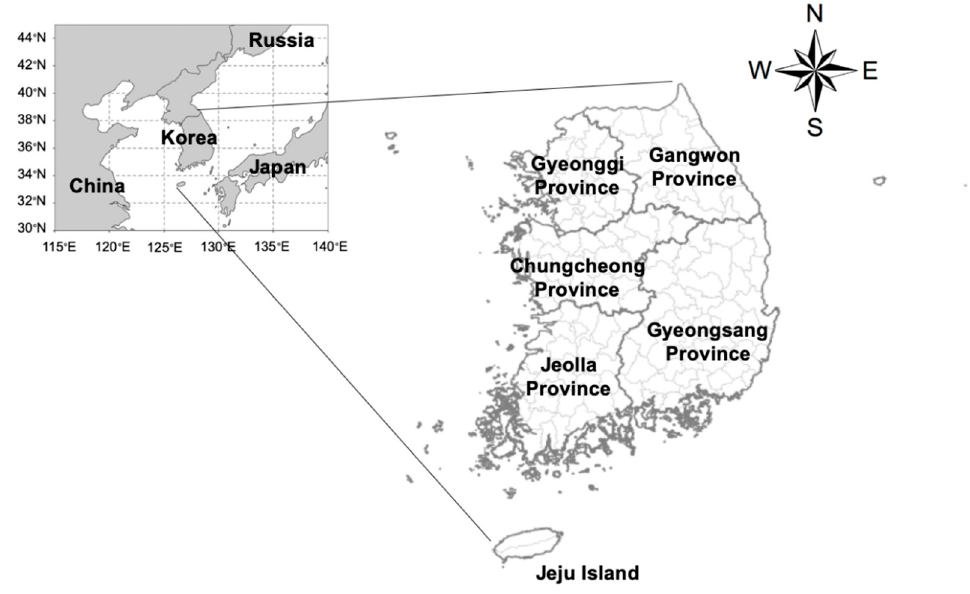
Figure 1. Study area, encompassing 167 government administrative districts.